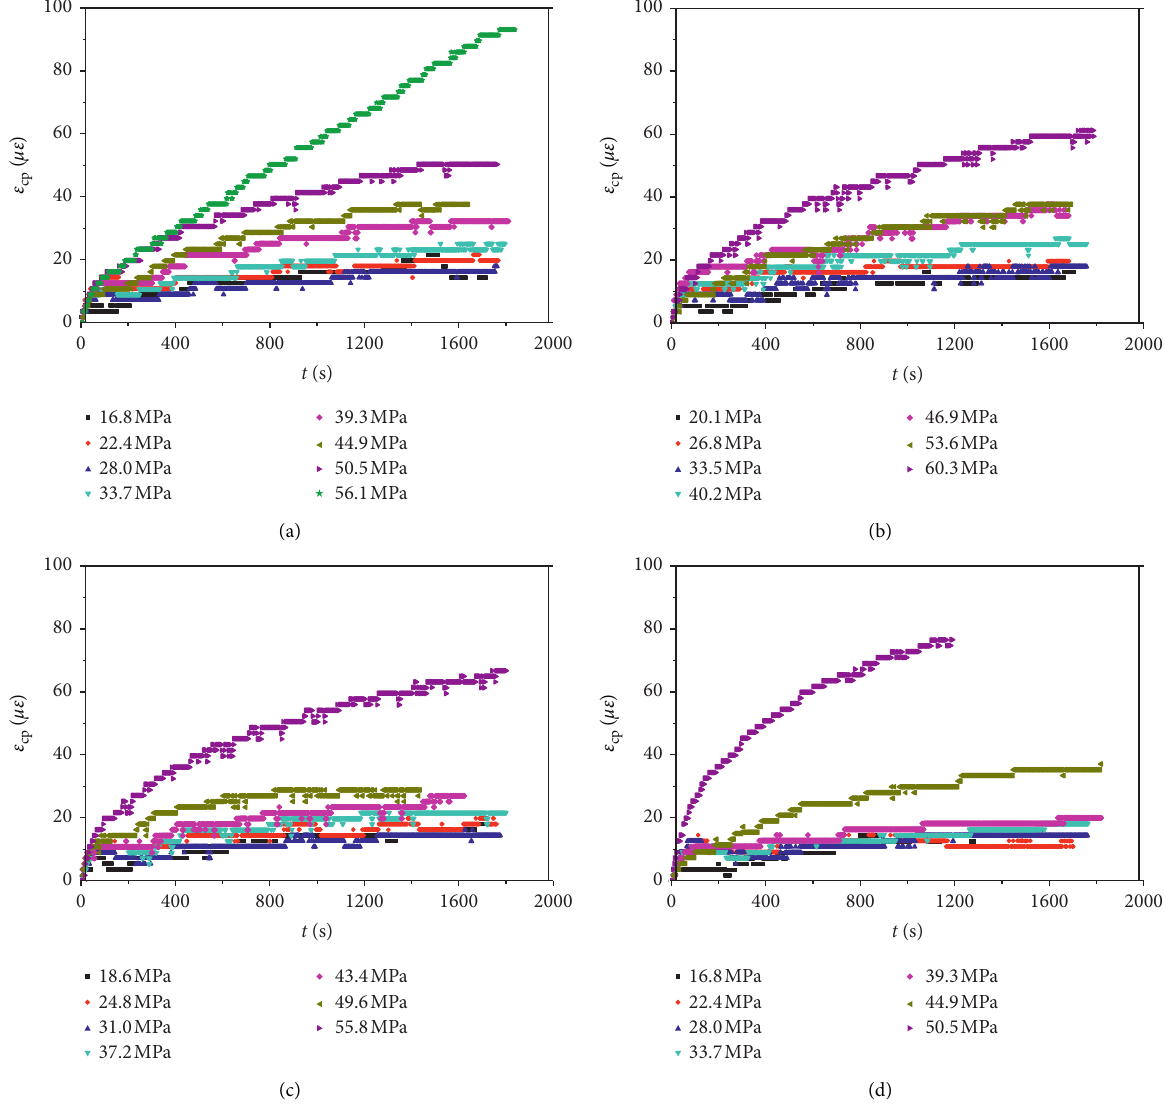
Figure 6: Creep strain-time curves ( ε cp - t ) of concrete with fly ash replacement ratios of (a) 0, (b) 20, (c) 35, and (d) 50 wt% under different stress